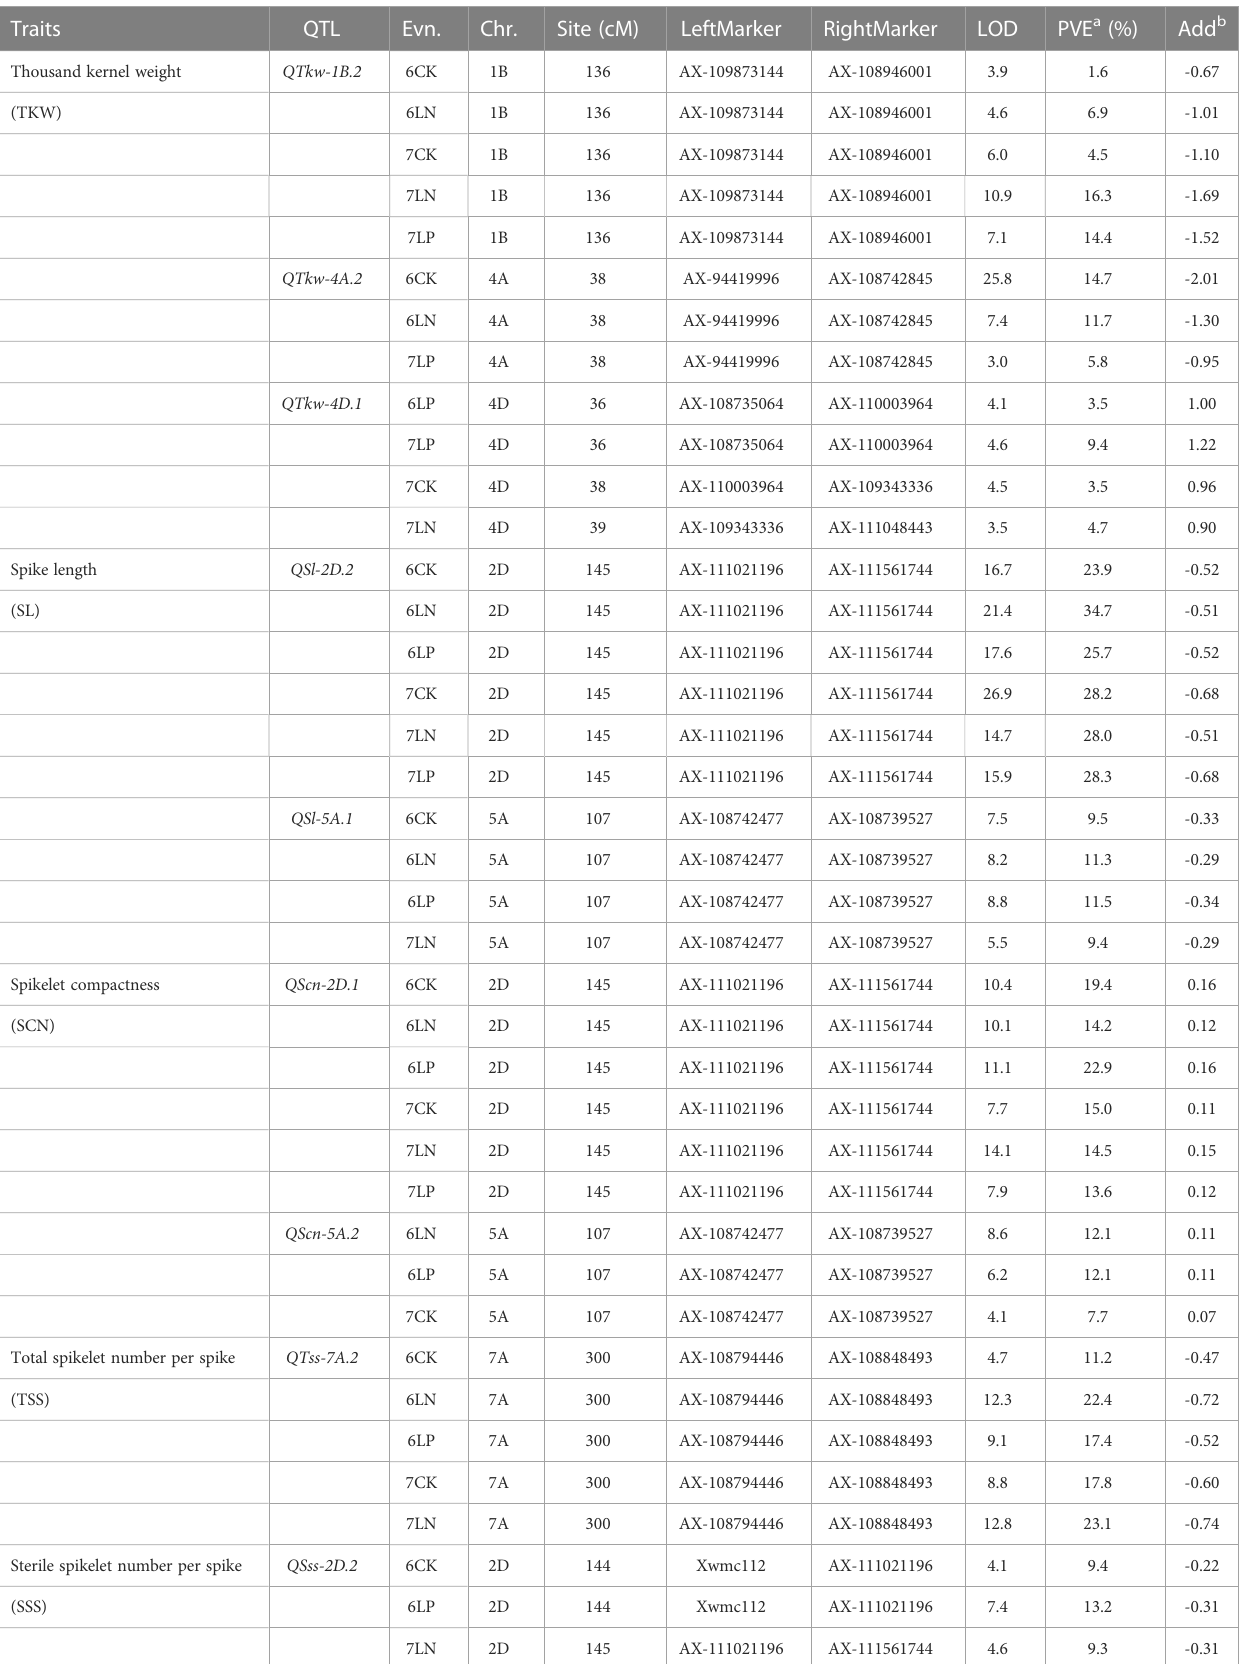
TABLE 2 Environmentally stable QTLs for each yield-related trait of Xiaoyan 54/Jing 411 RIL population in six environments. Traits QTL Evn. Chr. Site (cM) LeftMarker RightMarker LOD PVE a (%) Add b Thousand kernel weight QTkw-1B.2